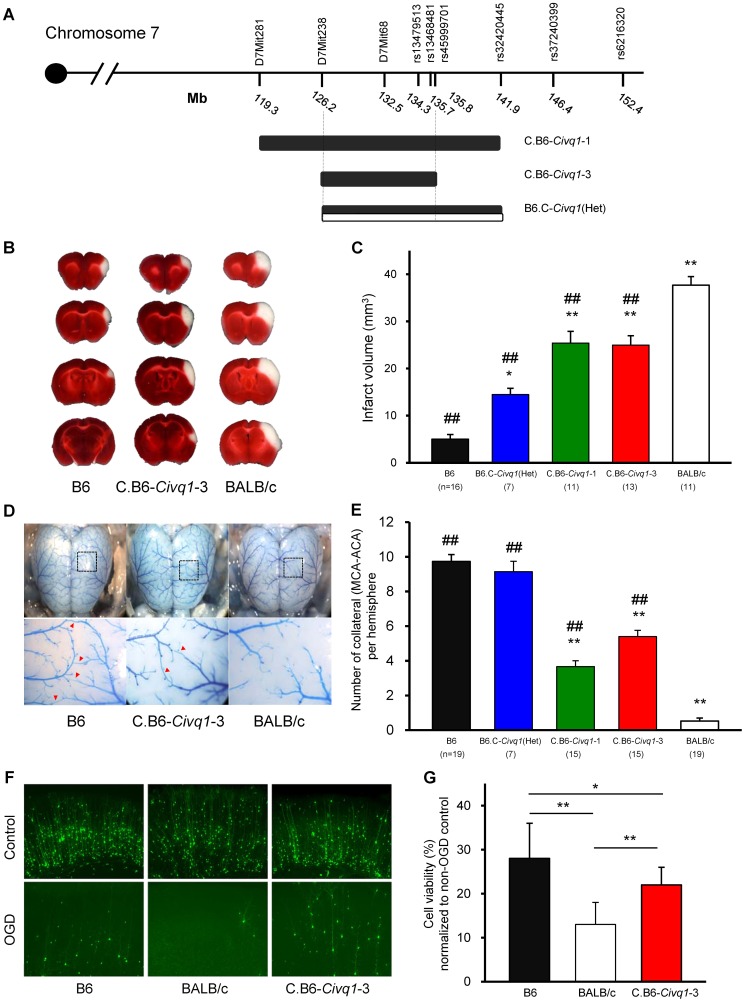
The critical interval of chromosome 7 retains both infarct volume and collateral artery number phenotypes in congenic animals.A. Schematic map of two Civq1 congenic lines carrying segments of B6 chromosome 7 introgressed into the BALB/c background, and heterozygous BALB/c alleles on B6 background. The latter could only be maintained as a heterozygote with B6. B. The posterior faces of representative 1-mm coronal sections from the B6, C.B6-Civq1-3, and BALB/c mice are shown. The size of the infarct is much smaller in C.B6-Civq1-3 than control BALB/c mouse. C. Congenic mice (C.B6-Civq1-1 and -3) exhibit a reduction in infarct volume by ∼30% compared to BALB/c mice. Infarct volume in congenic mice carrying heterozygous BALB/c alleles on B6 background (B6.C-Civq1(HET)) is 2.5-fold larger than that of control B6 mice. ## P<0.001 vs. BALB/c; *P<0.05, ** P<0.001 vs. B6. Values represent mean ± SEM. D. Superficial angioarchitecture of the brain in 4-week old B6, C.B6-Civq1-3, and BALB/c mice. Magnified images of the box in the upper panels are shown in the lower panels. The red arrowheads indicate the vessels of pial anastomoses between the MCA and ACA. E. C.B6-Civq1 congenic lines show an increase in the number of collaterals connecting the distal MCA and ACA compared control BALB/c strains. Heterozygous congenic mice show no difference compared to control B6 mice. ## P<0.001 vs. BALB/c; ** P<0.001 vs. B6. F. Cortical brain slices from B6, BALB/c, and C.B6-Civq1-3 mice biolistically transfected with an YFP expression plasmid under normal conditions and 24 hr after 5.5 min of OGD. G. C.B6-Civq1-3 mice exhibit ∼50% increased neuronal viability compared to control BABL/c mice. Total numbers of healthy and YFP-positive neurons in the cortical region of the brain slices were counted at 24 hr after transient OGD. Cell viability was normalized from their non-OGD controls. Values represent mean±SEM from at least 5 animals per group. * P<0.05 and ** P<0.001.